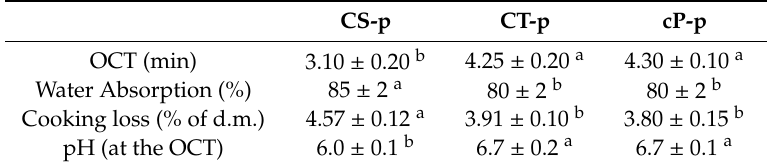
Table 5. Main technological properties of the fresh pasta: CS-p, semolina fresh pasta fortified with the chickpea sourdough; CT-p, conventional semolina fresh pasta; CT-p, cP-p semolina fresh pasta added to 0.3% (w / w on a flour weight basis) calcium